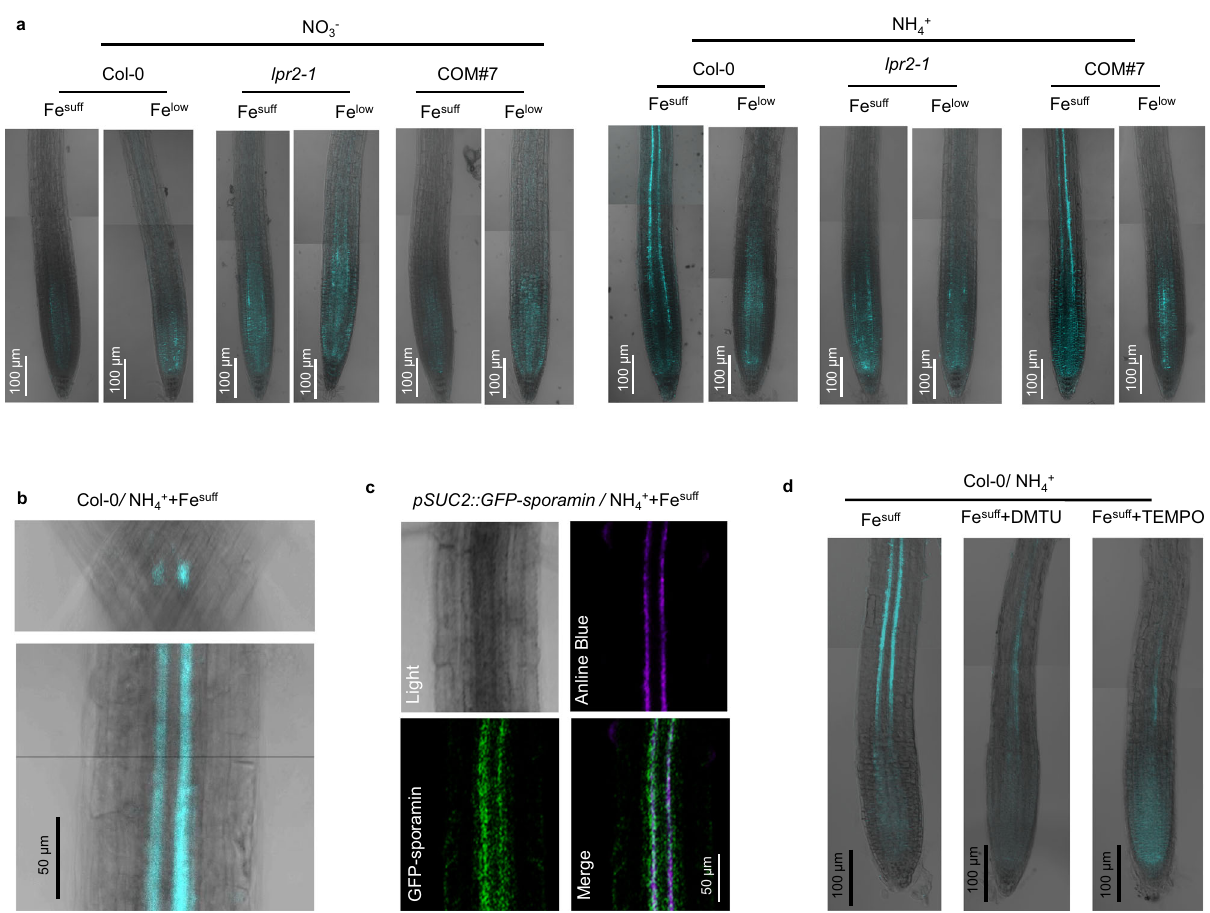
Fig. 6 Fe-dependent callose deposition in the phloem via reactive oxygen species (ROS) in response to NH4 + . a Callose detection in primary roots of Col-0, lpr2-1 , and complementation line COM#7 seedlings by aniline blue staining. b Radial section (top) and close-up view (bottom) of aniline blue staining in primary roots of Col-0 seedlings grown in Fe suff NH 4 + medium. c Fluorescence co-localization of GFP-sporamin and aniline blue staining in pSUC2::GFP-sporamin roots. d ROS scavengers abolished the NH 4 + -induced callose deposition. Four-day-old seedlings of the indicated genotypes were transferred to NO 3 − or NH 4 + medium with Fe suff (100 µ M) or Fe low (10 µ M) with or without the indicated ROS scavenger. Each experiment was repeated independently three times with similar results, and a representative experiment is